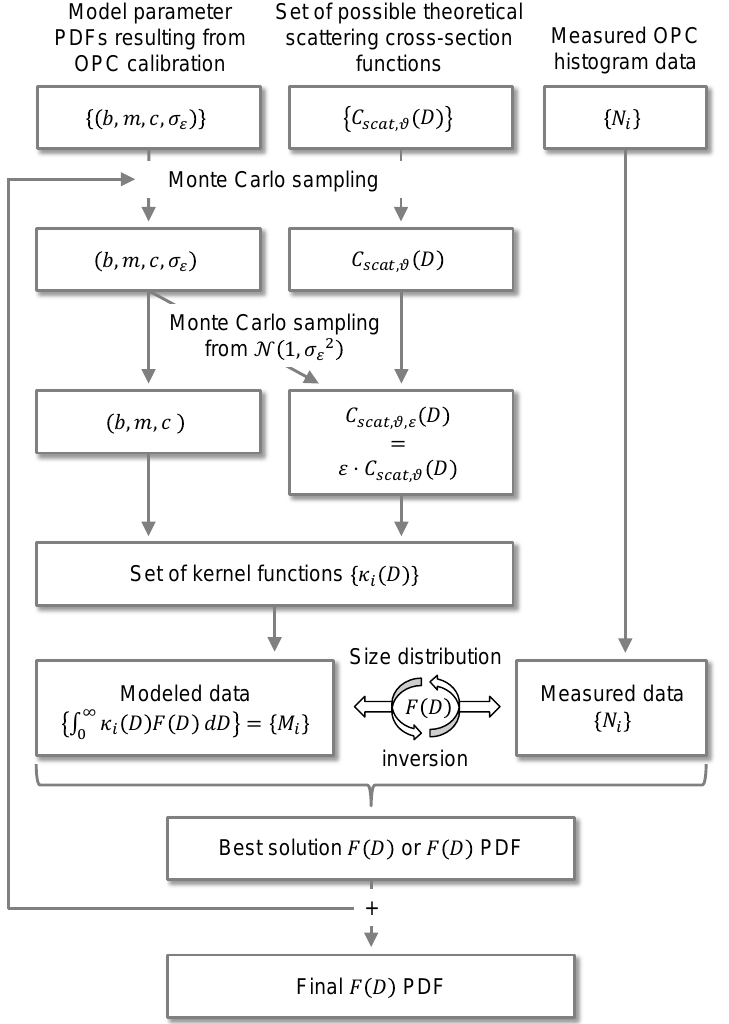
Figure 3. Flow chart demonstrating a possible pathway for the retrieval of size distribution information from OPC histogram data within the new